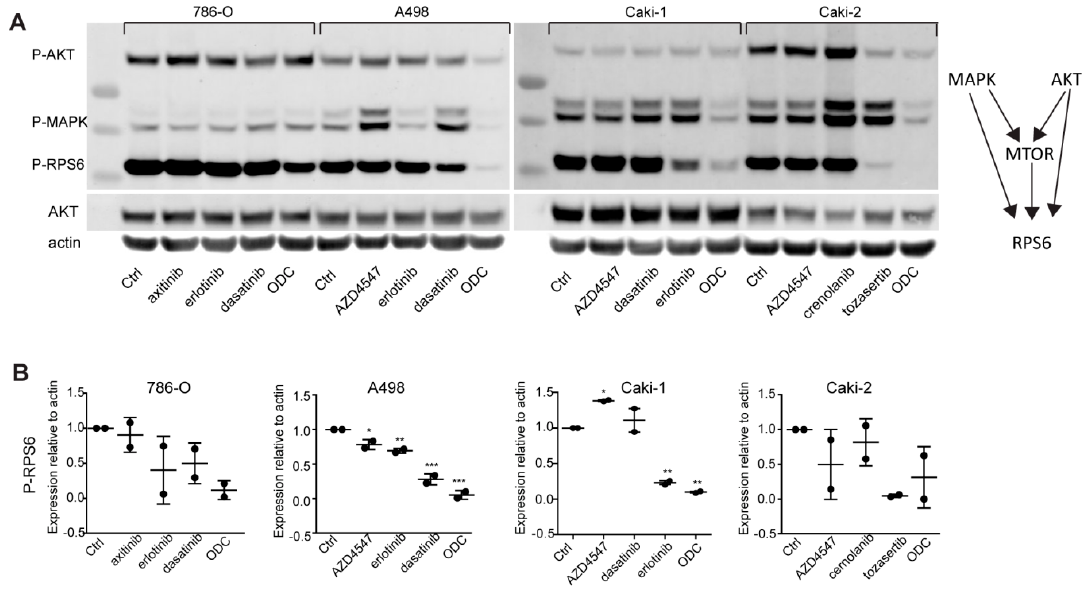
Figure 2. ODC induce cell cycle inhibition mediated through RPS6. Western blot analysis ( A ) and densitometric quantification ( B ) of monotherapy and ODC treated RCC, covering major cellular survival pathways that converge to RPS6. Clear inhibition of RPS6 phosphorylation is seen in all cell lines. Experiments were performed in duplicate and representative blots are shown. *: p < 0.05, **: p < 0.025, ***: p < 0.01.